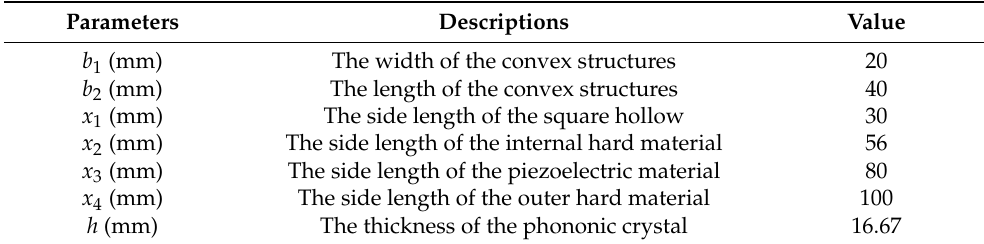
Table 2. Geometric characteristics of the established piezoelectric phononic